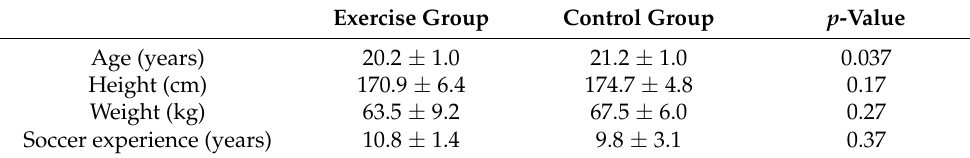
Table 1. Baseline characteristics of the trunk stabilization exercise group and control group. Exercise Group Control Group p -Value